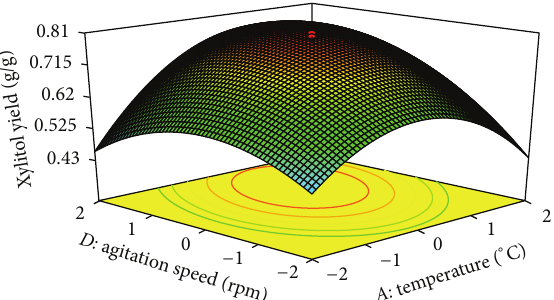
Figure 5: 3D plot showing the effect of temperature and substrate concentration on xylitol yield.